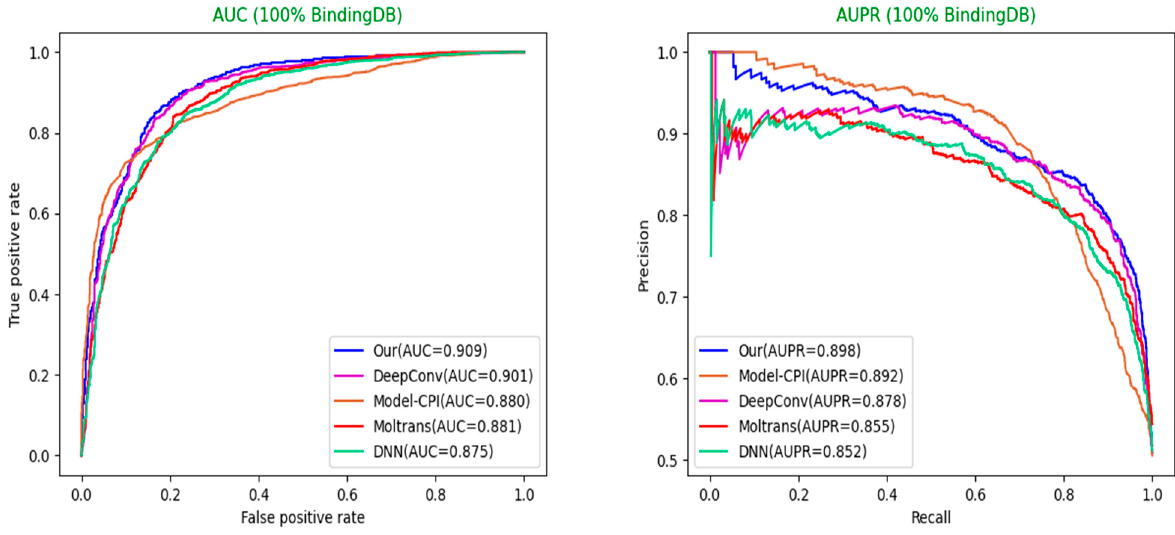
Figure 6. Our model achieves the best AUC and AUPR on 100% BindingDB dataset (Our = Multi- TransDTI).